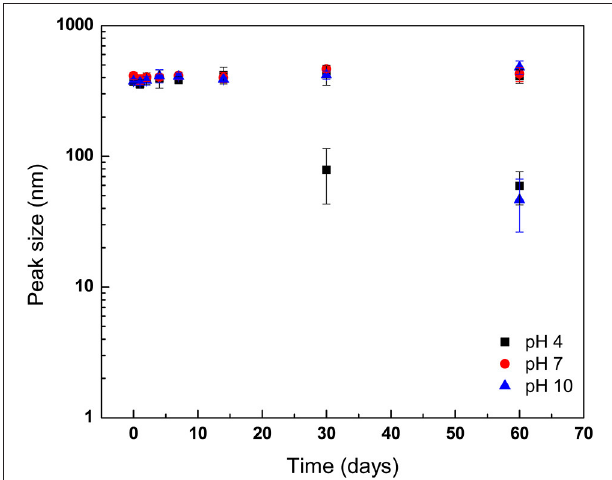
FIGURE 4 | Stability of geraniol-loaded nanoparticles over 60 days of storage in milli-Q water (25 ◦ C) as a function of storage pH. Storage solution pH was modified by controlled addition of 0.133mM HCl or NaOH. Particle size and polydispersity was determined by dynamic light scattering. Symbols depict means taken from two identical independent replications, with duplicate readings taken per sample and then averaged ( N = 2); error bars indicate one sample standard deviation.